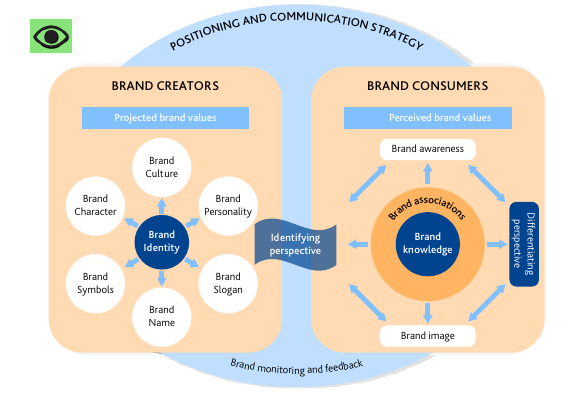
Figure 1. Destination branding